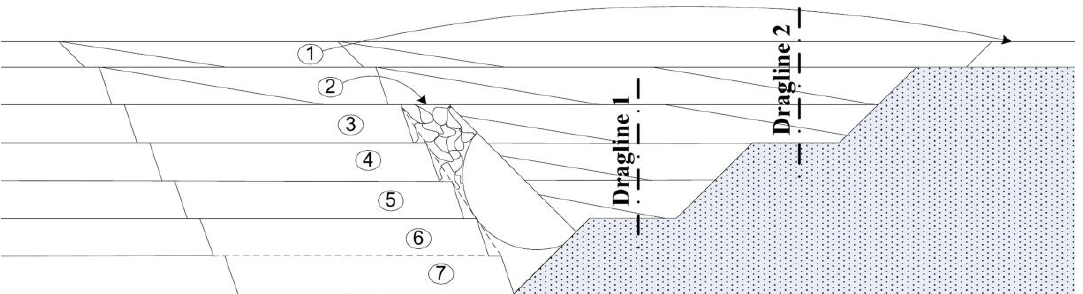
Figure 6. The scheme of excavation of overburden from the layer to the internal dump.